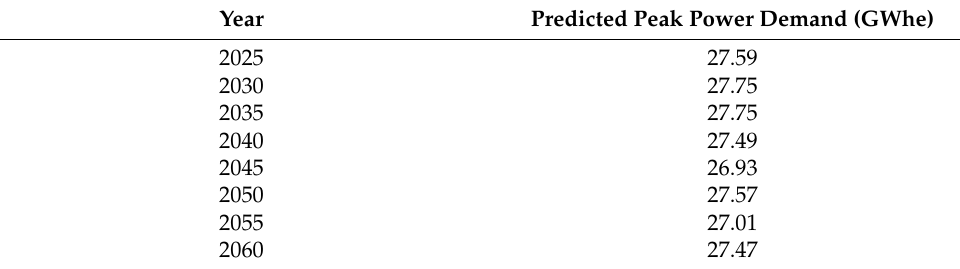
Table 6. Peak power demand predicted by the neural network.